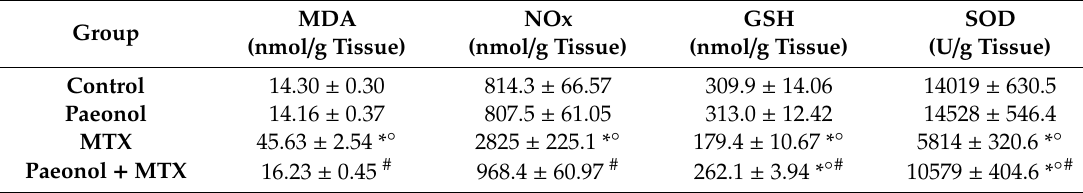
Table 3. E ff ect of paeonol on oxidative stress